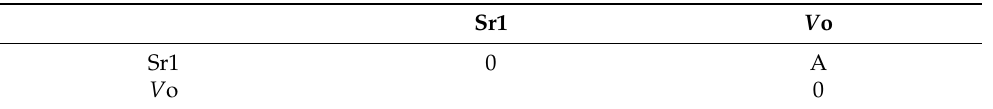
Table A5. Configurational Matrix (mutual interatomic distances in NN, as in Table A2) for x = 0.0625, δ = 0.0625. Five configurations (A), as in Table A10.